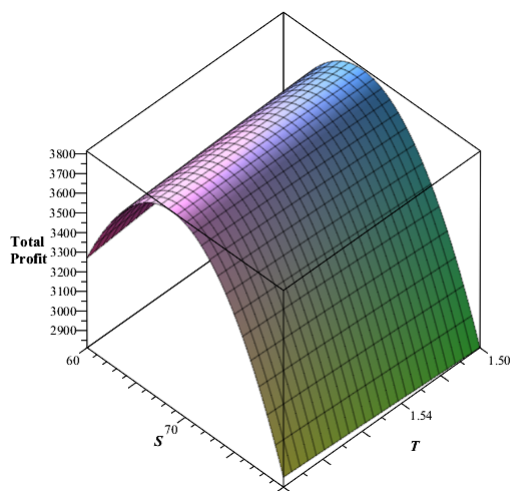
Figure 3. Optimality of a total profit function for situation 2 (0 < t n < M < T ). Illustration 3: For situation-(iii): 0 < t n < T <